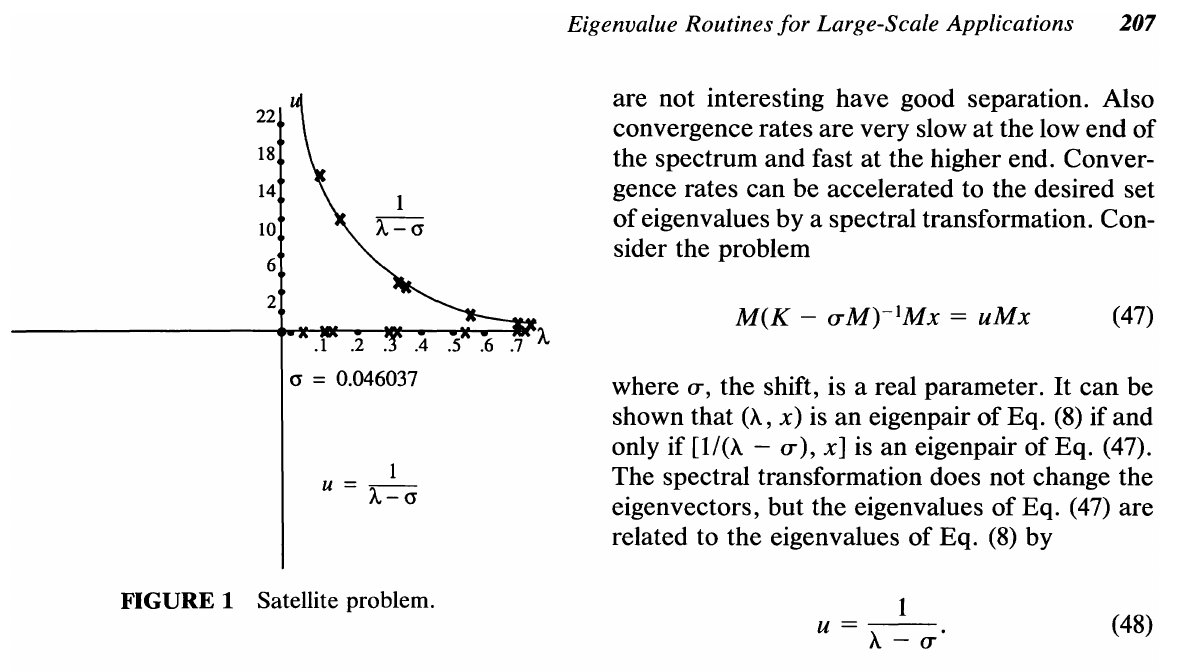
FIGURE 1 Satellite